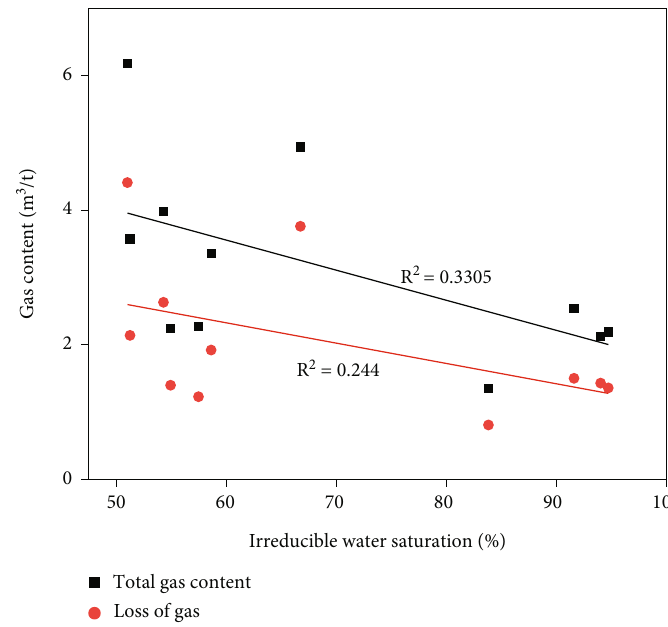
Figure 19: Relationships between the bound water saturation and the gas